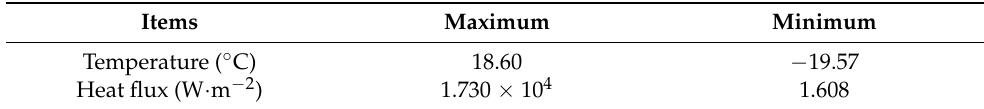
Table 6. Extreme values of temperature and heat